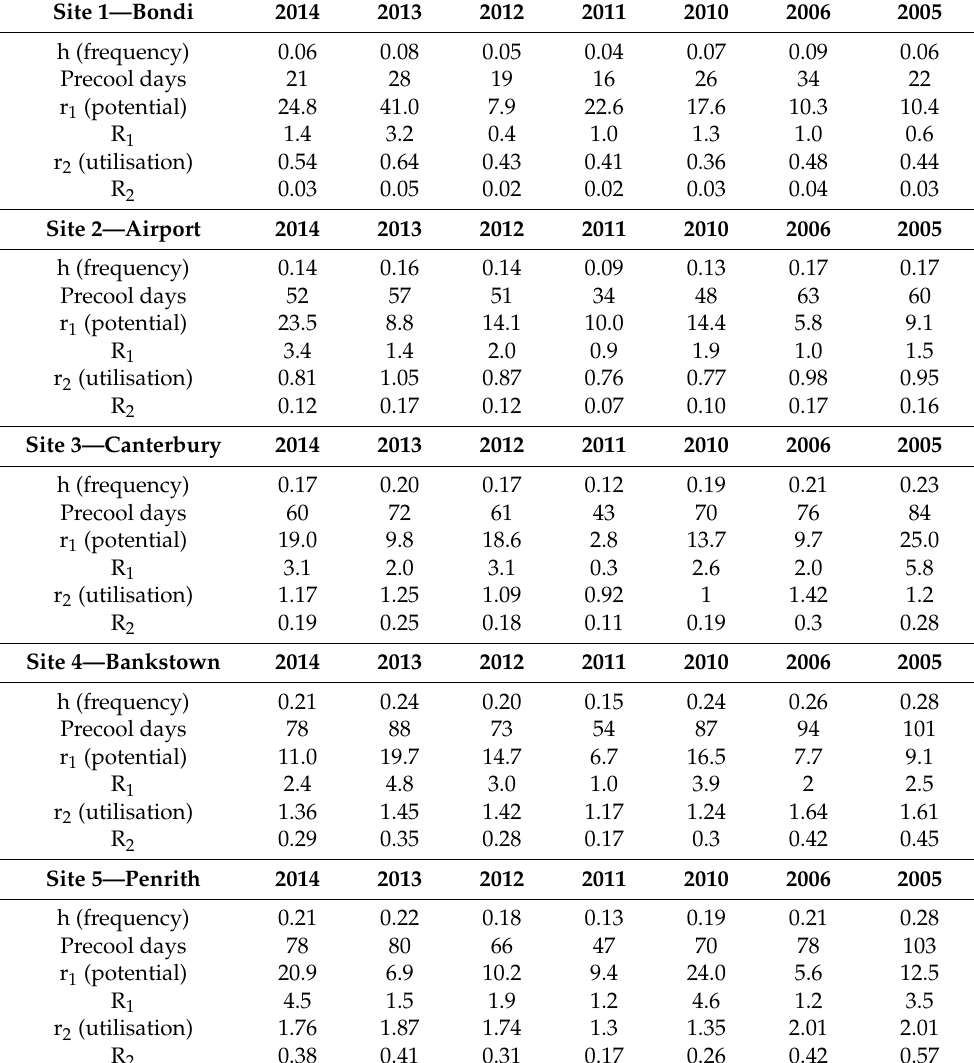
Table 4. Summary of results across five sites in Sydney for each simulation year.